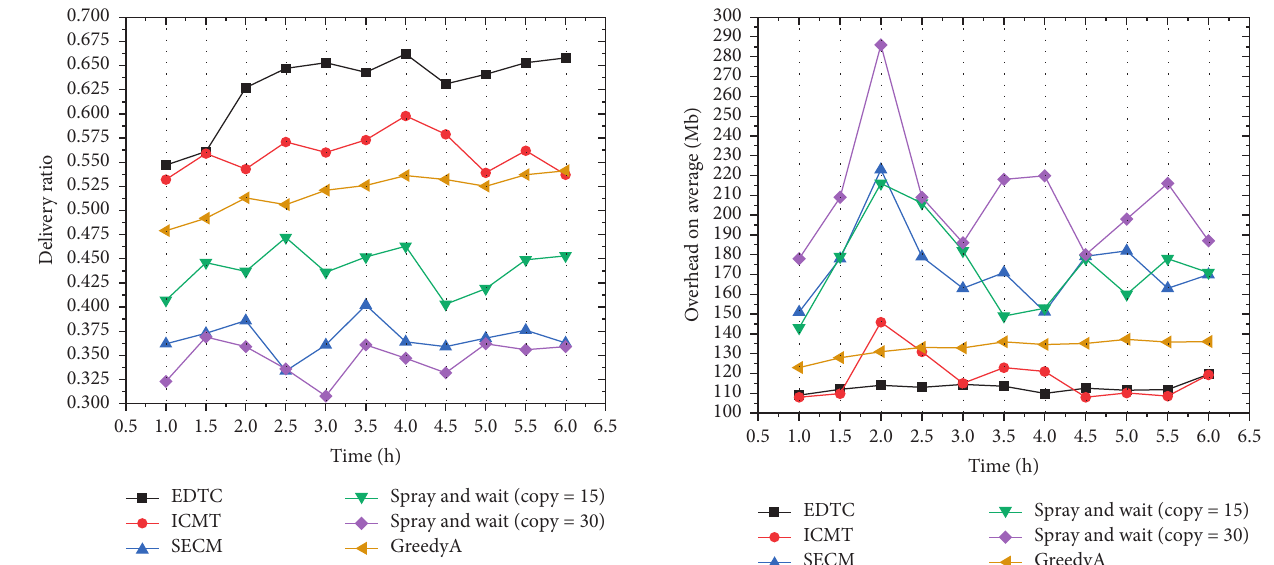
Figure 13: Relationship between routing overhead and time.